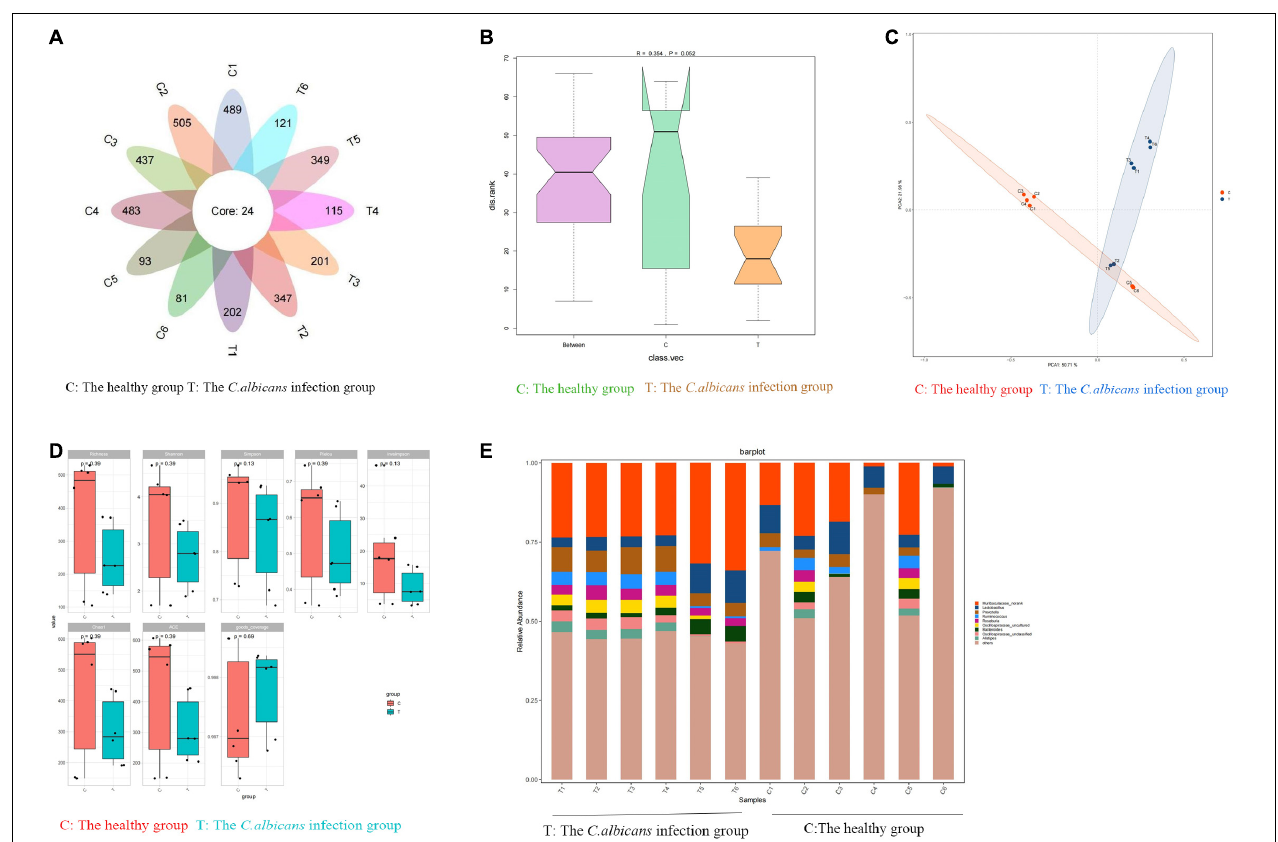
FIGURE 2 | Invasive C. albicans infection disrupts fecal microbiota in humans. Human fecal samples were collected from healthy people ( n = 6) and patients with candidemia ( n = 6). 16S rRNA gene amplicon sequencing and metabolomic analysis were done to investigate the bacterial composition and intestinal metabolites. (A) The petal diagram of OTU distribution. (B) Analysis of similarities (ANOSIM). (C) The PCA analysis of OTU abundance. (D) Alpha-diversity analysis. (E) At the genus level, invasive C. albicans infection disrupts fecal microbiota diversity. T, The Candida albicans infection group; C, The healthy control group.